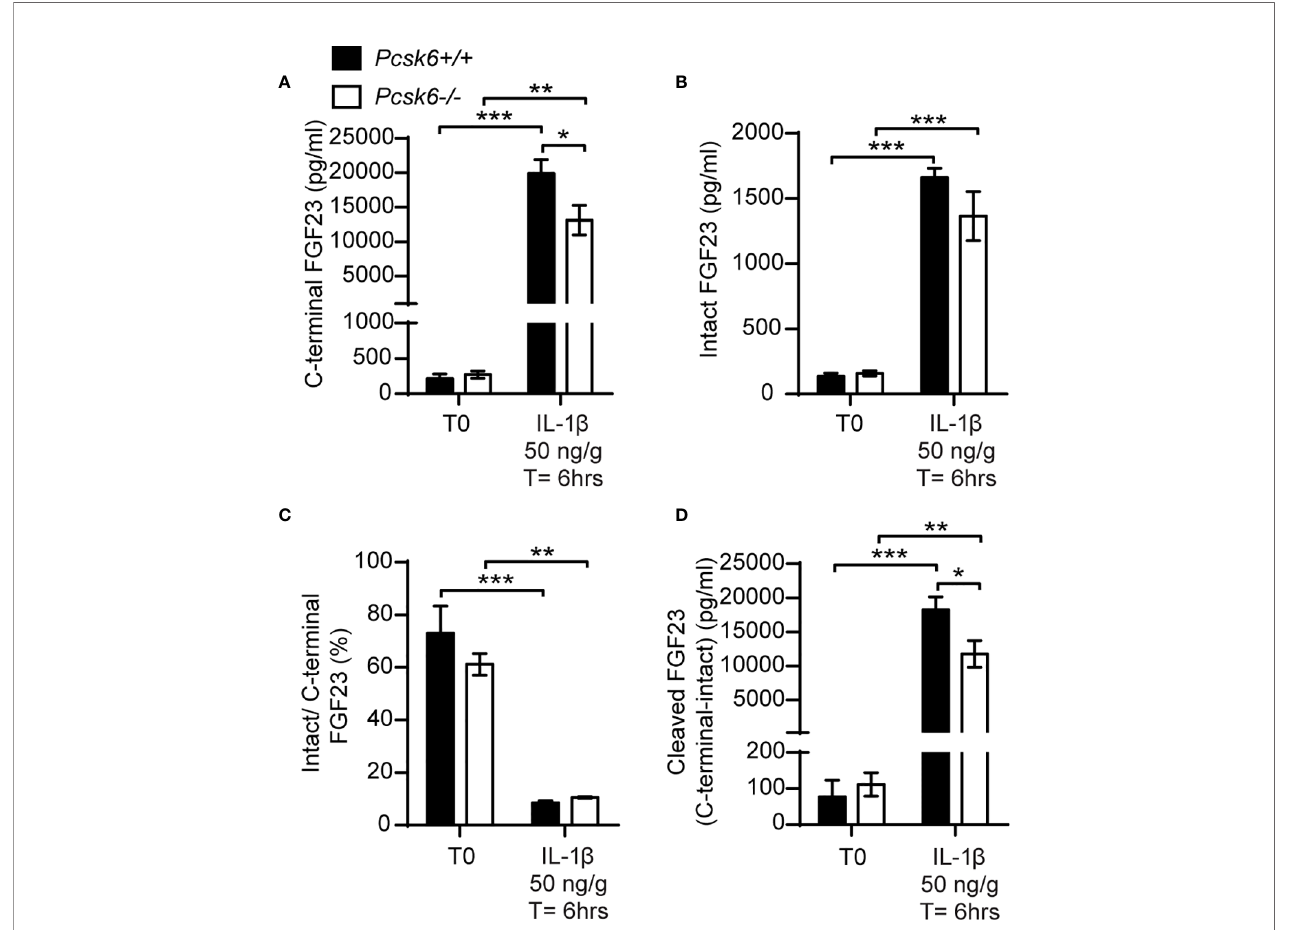
FIGURE 7 | PACE4 inactivation in mice does not impair FGF23 processing. Plasma FGF23 measurements in 4-month-old Pcsk6 +/+ (n=4) and Pcsk6 -/- (n=4) male mice before (T0) and 6 hours following the injection of 50 ng/g of IL-1 b : C-terminal FGF23 (A) , intact FGF23 (B) , percentage (%) of intact over C-terminal FGF23 (C) , and cleaved FGF23 levels (D) , calculated as (C-terminal FGF23) - (intact FGF23). Results represent the mean ± SEM. * P < 0.01, ** P < 0.01 and *** P < 0.001, by 2-way ANOVA with Bonferroni ’ s multiple comparisons